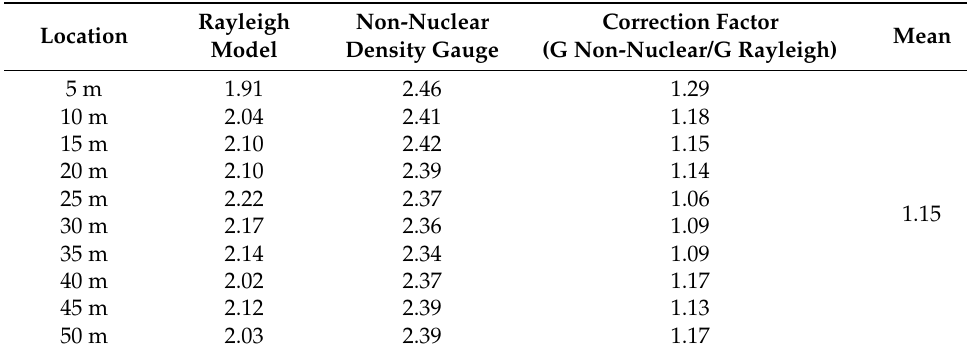
Table 8. Density correction factor of the Rayleigh